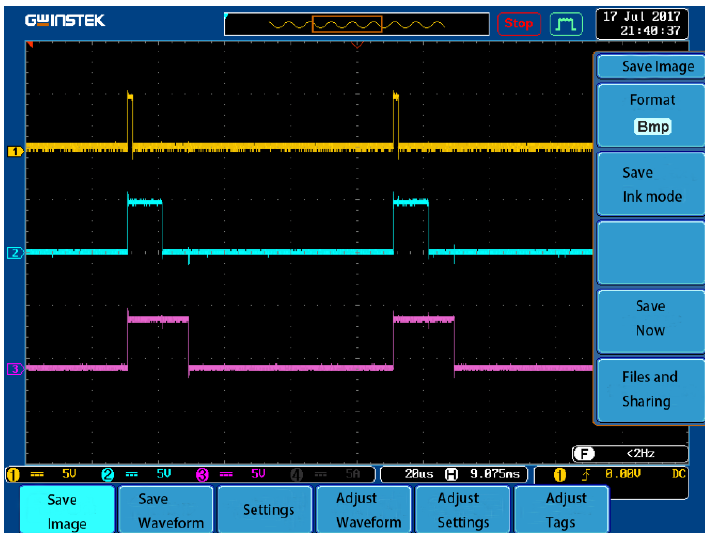
Figure 12. Output voltage of the SVPWM signal in region 4 of the vector distribution map.